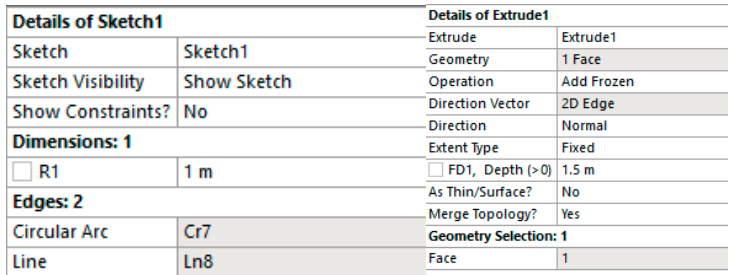
Figure 12. Details of the flow domains sketch.